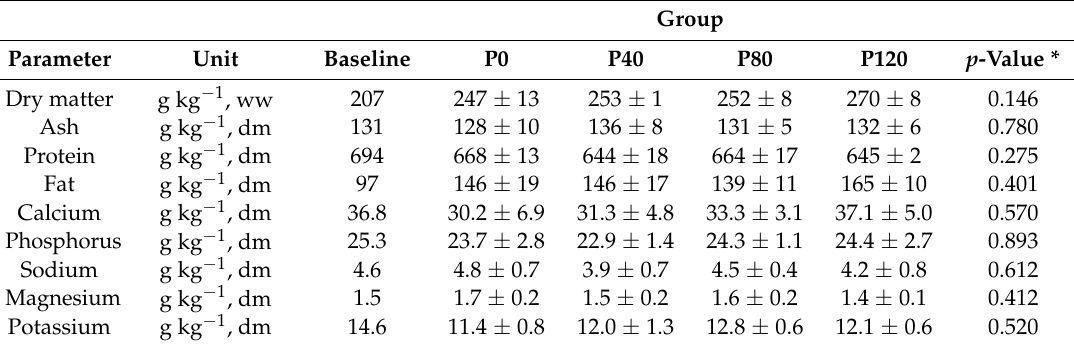
Table 3. Initial and final body composition of C. gariepinus (n = 3).